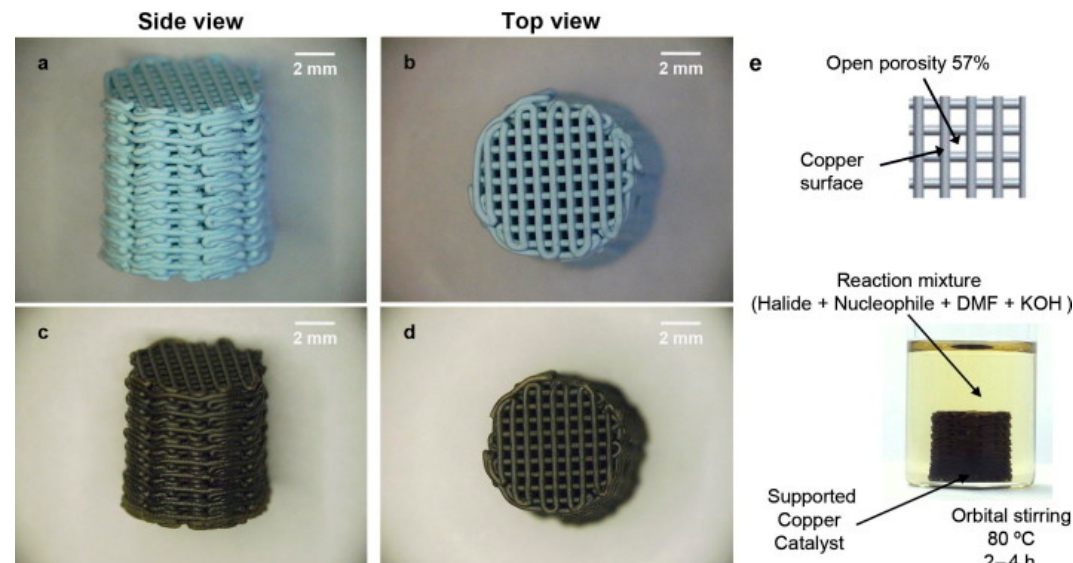
Figure 9. Optical images of the Cu/Al 2 O 3 structure: dried ( a , b ) and sintered ( c , d ). Schematic illustration and image of the experimental set used for catalytic tests ( e ). Reprinted from Ref. [157] with permission from Journal of Catalysis.